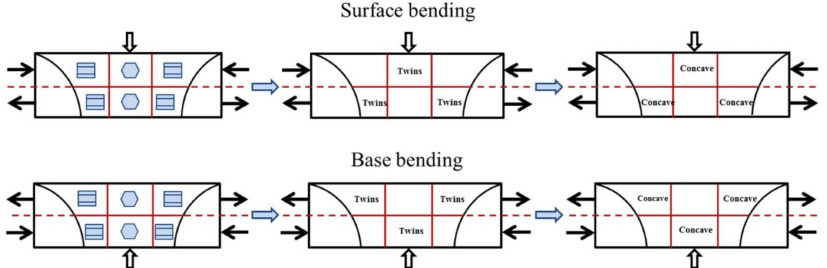
Figure 7. The schematic diagram of the stress distribution, twinning activation and surface change of welding